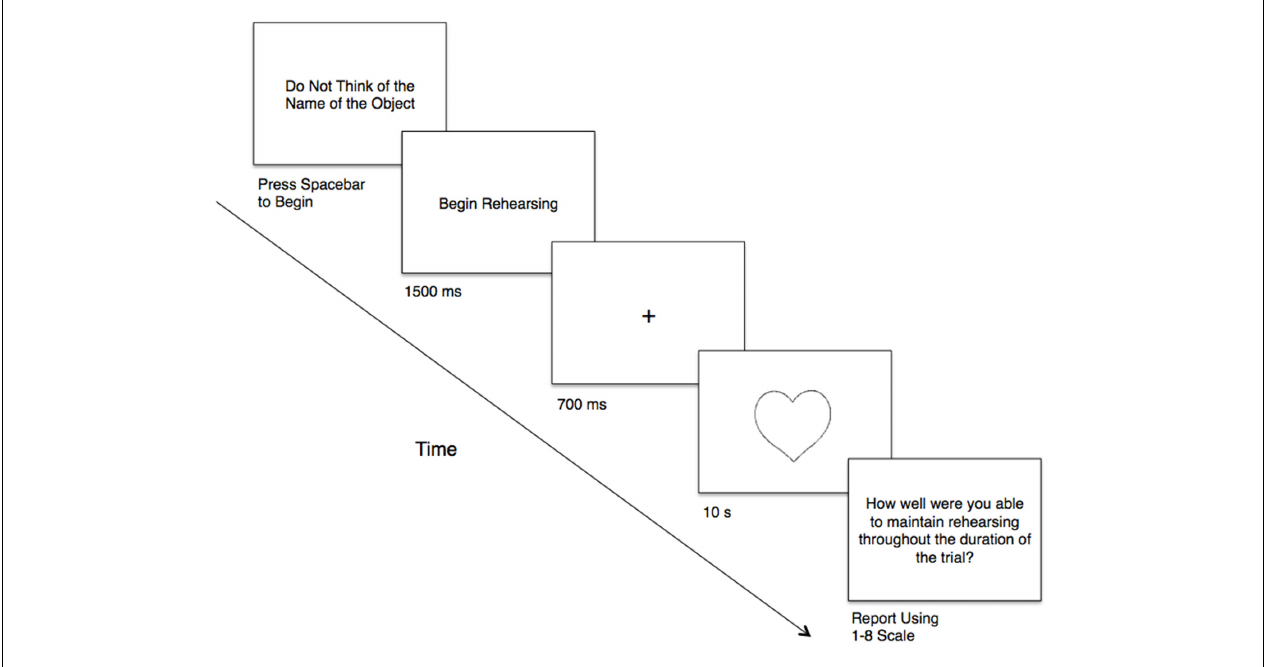
FIGURE 1 | Schematic depiction of a typical trial. Not drawn to